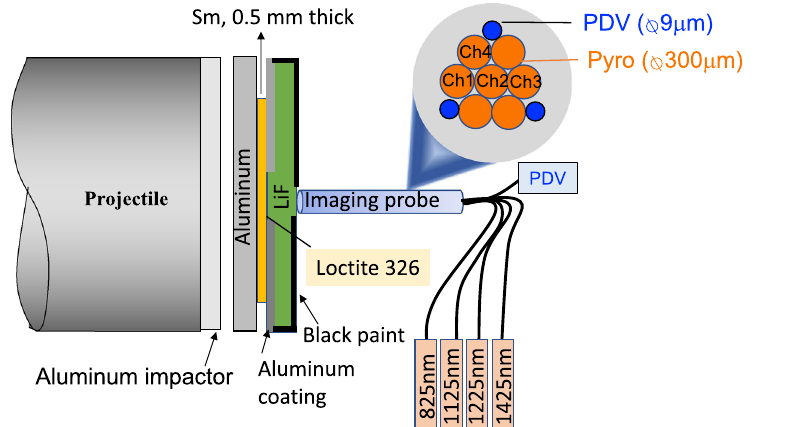
Figure 5. Plate-impact experiment schematic.